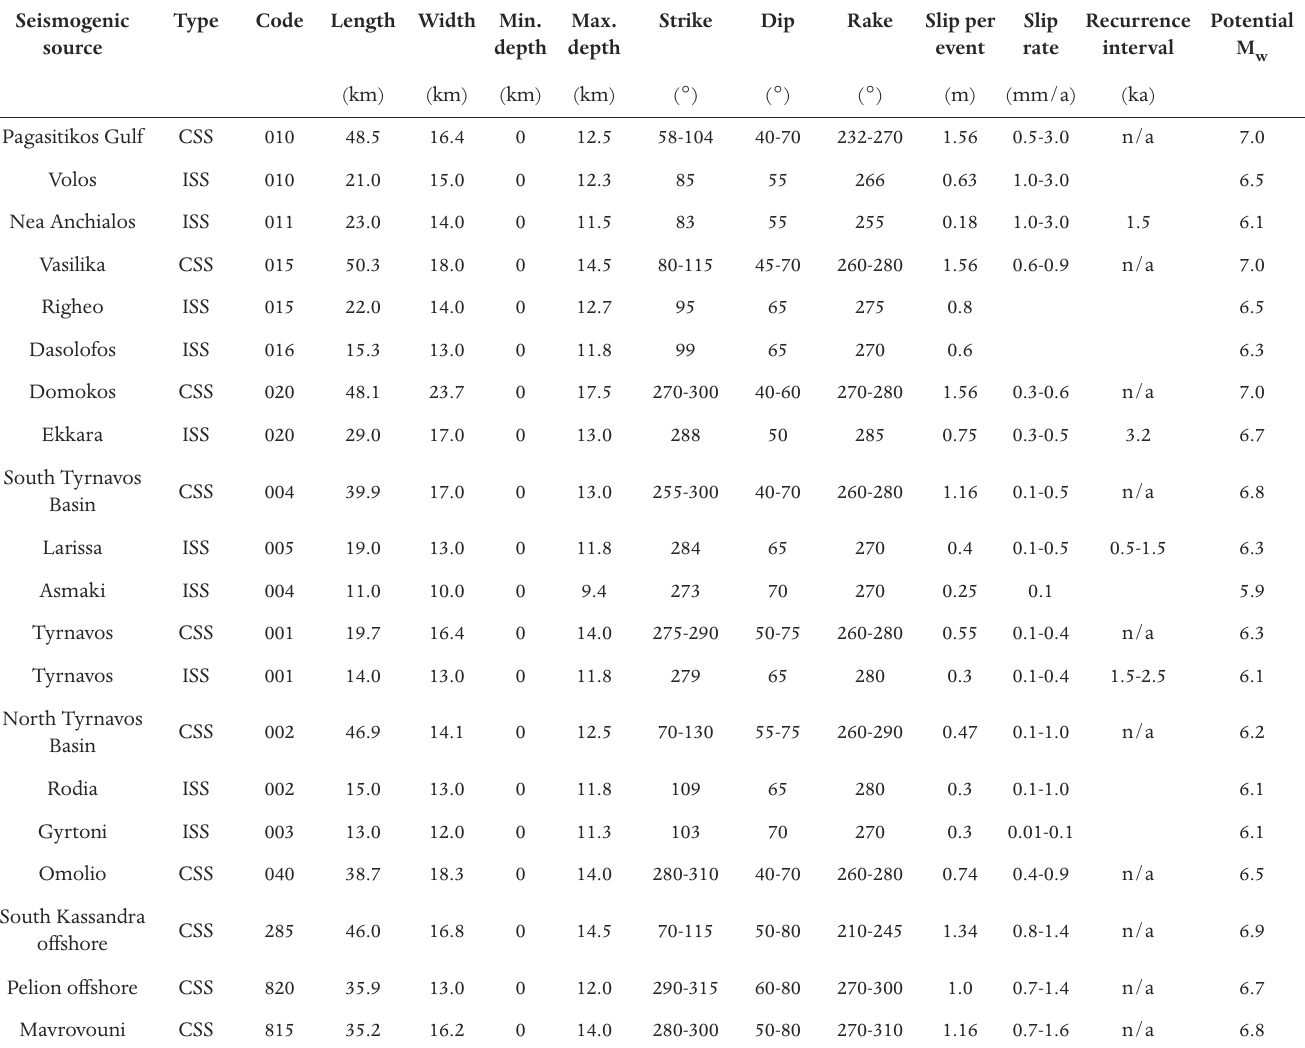
Table 6. Seismotectonic parameters of the CSSs and ISSs included in the Thessalian fault system (see Figure 7). CSS, composite seismogenic source; ISS, individual seismogenic source; Code, identification number within the database; n/a, not